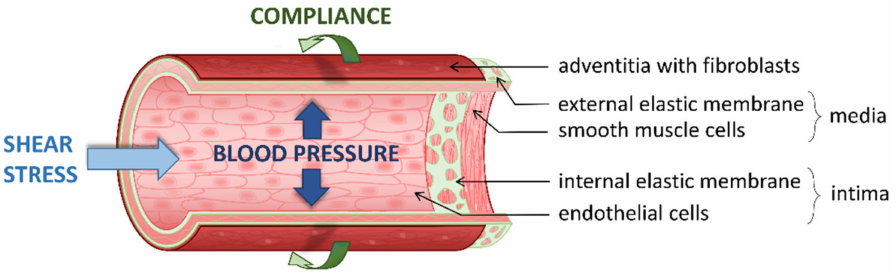
Figure 1. Hemodynamic forces acting on the vessel wall. Section of an artery wall showing that the endothelial cells, forming the inner tunica, are longitudinally aligned, whereas smooth muscle cells, forming the median layer, are circumferentially aligned; the surrounding adventitia predominantly includes fibroblasts and matrix. Shear stress, frictional force generated by blood flow, is parallel to the vessel wall, whereas blood pressure is perpendicular to the vessel wall, causing circumferential and longitudinal stretching. Beside blood mechanical forces, composition of extracellular matrix, contributing to arterial stiffness, may itself modulate compliance and mechanotransduction in the vessel